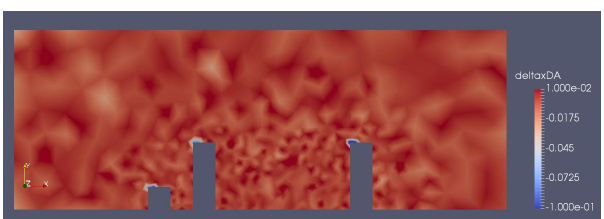
Fig. 9 Results of the VarDA algorithm with (cid:28)(cid:28)(cid:28) =155 EOFs for Velocity field.